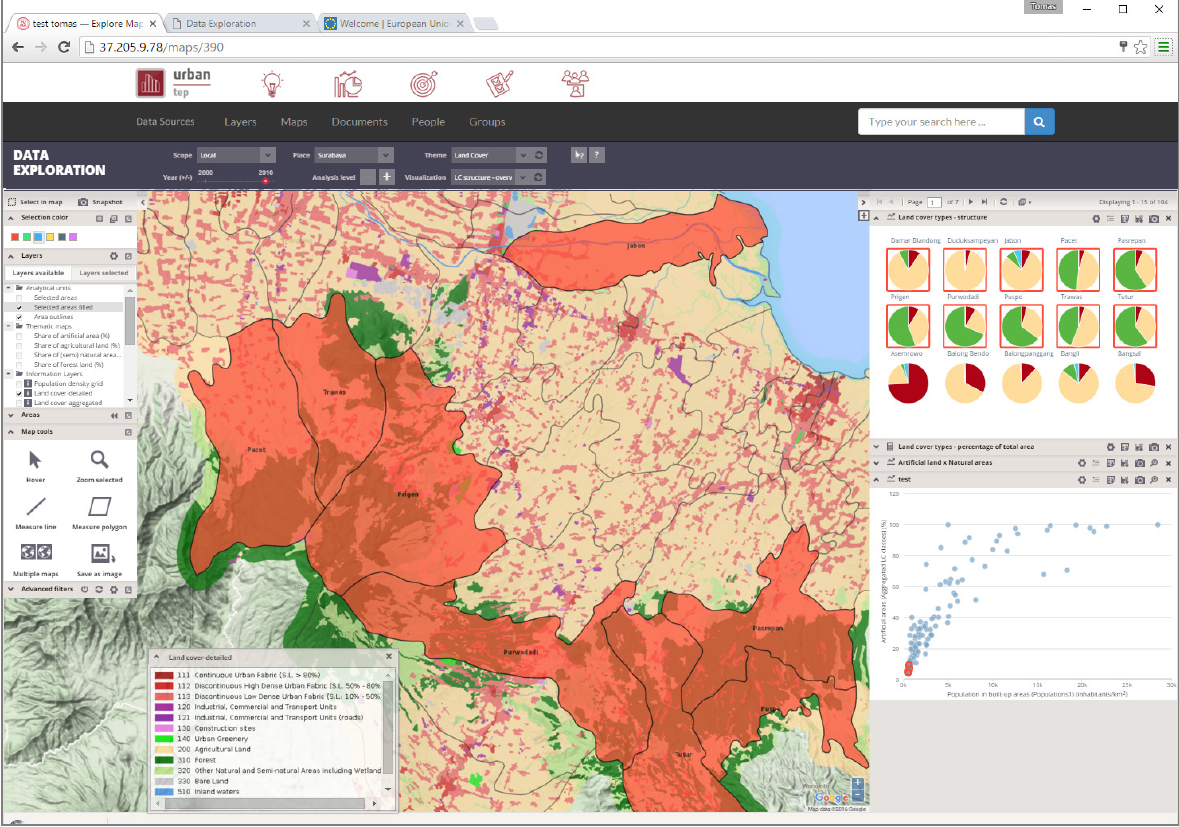
Figure 2. Interface of U-TEP service for customized analysis and visualization of data and